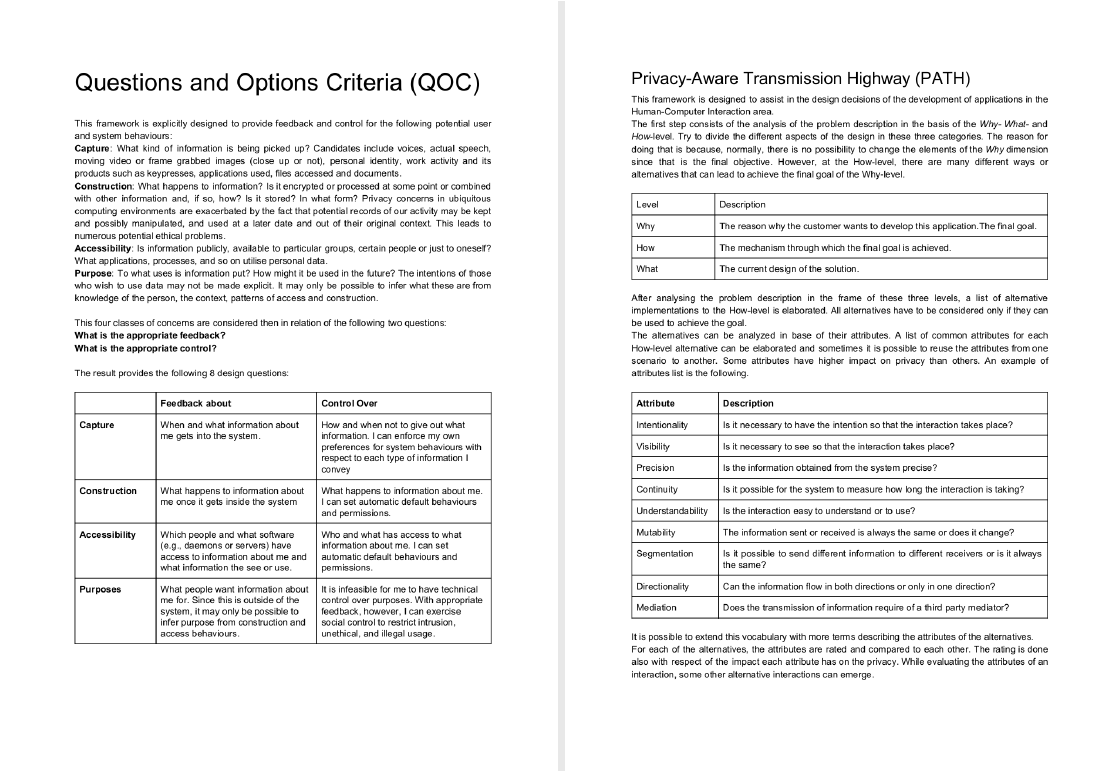
Figure 2. Summary of the QOC-FC framework ( left ) and the PATH framework ( right